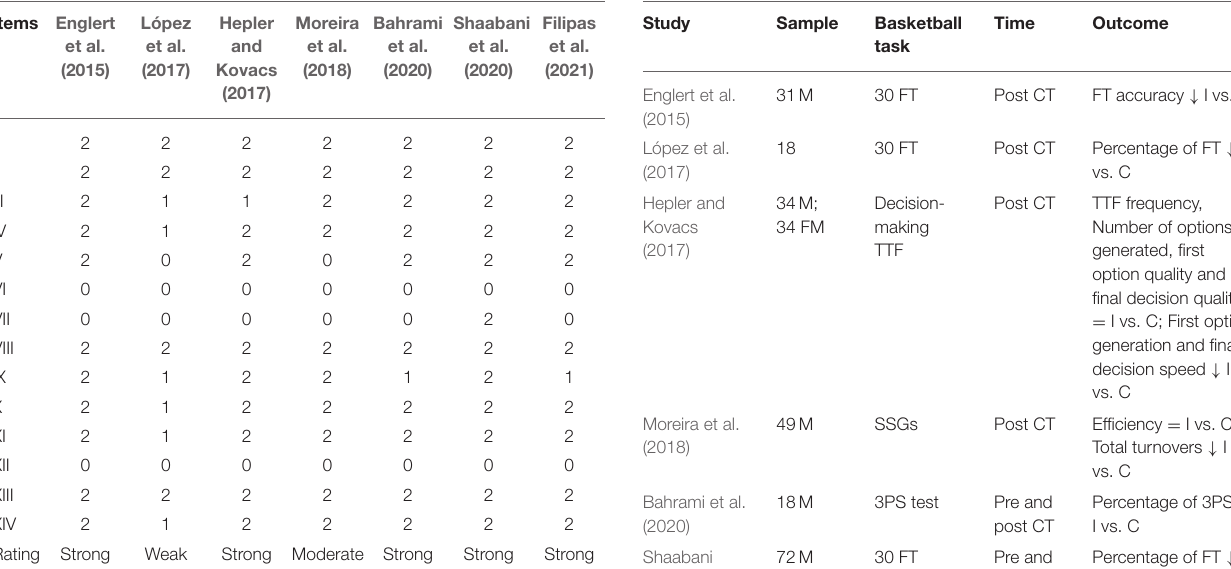
TABLE 4 | Overview of the mental fatigue on basketball performance.